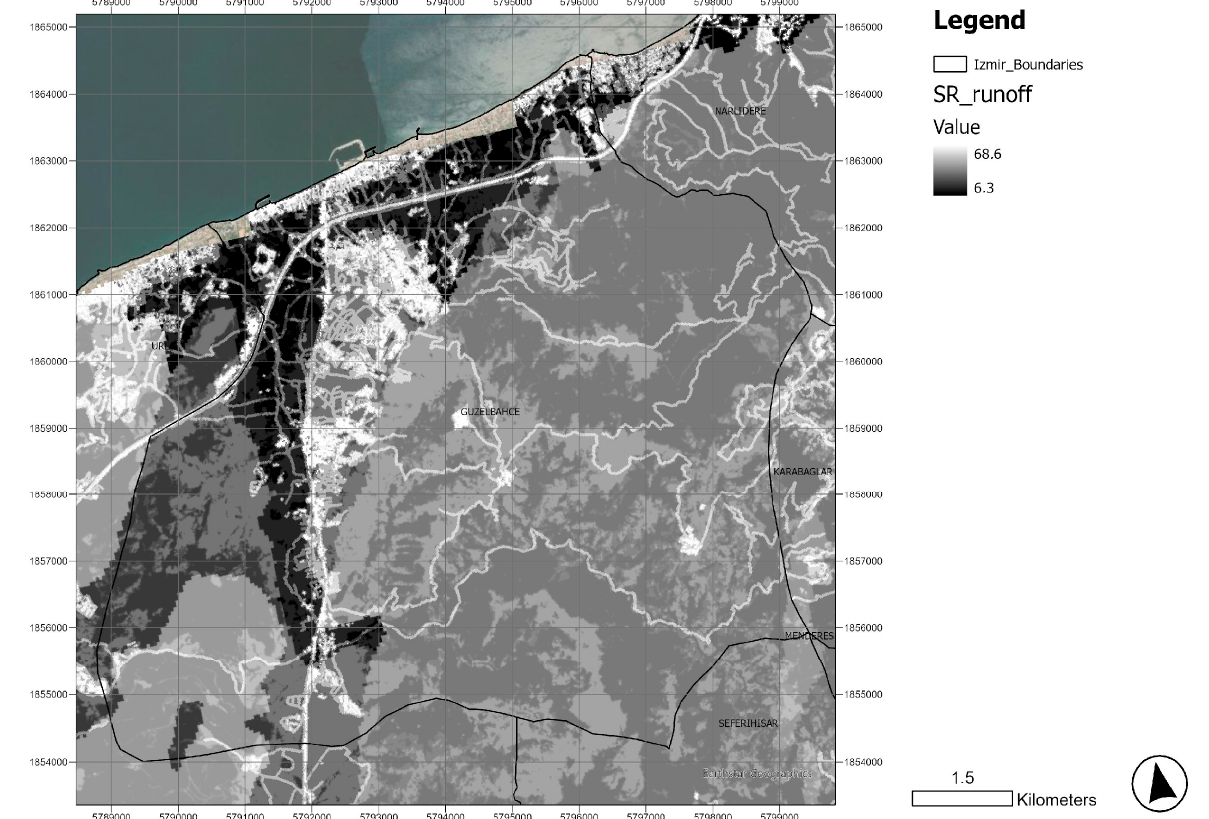
Figure 7. Guzelbahce’s annual runoff. Source: InVEST output.